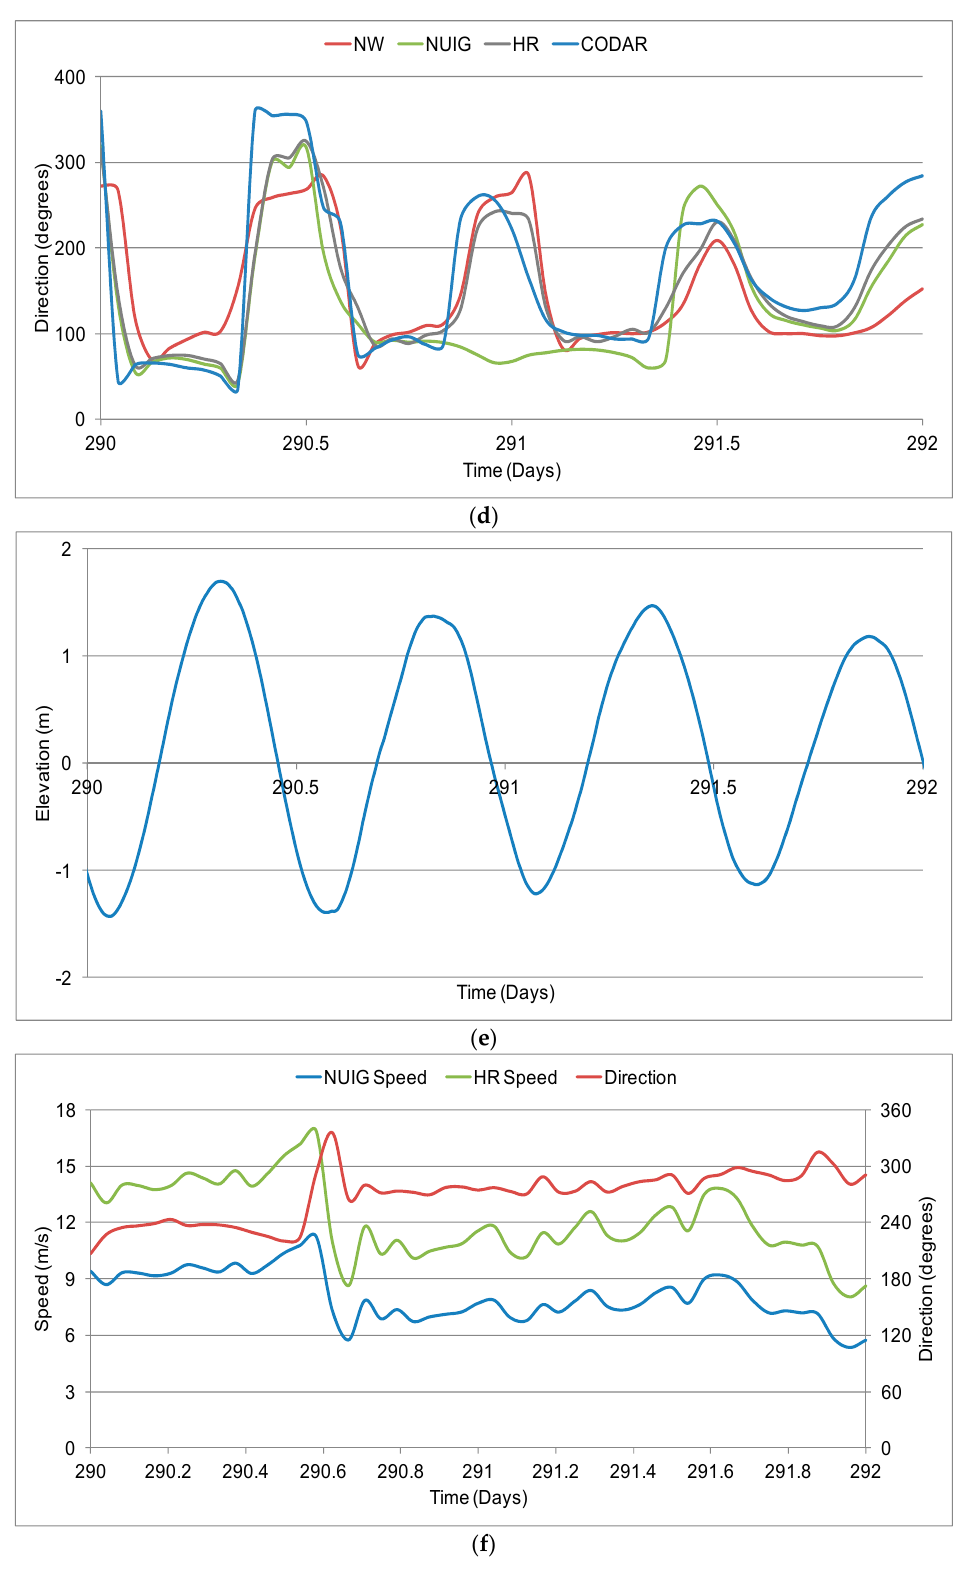
Figure 12. Comparison of model results and observations at location C3 during P1 (( a , b ) east-west (u) and north-south (v) surface velocity components from models and measurements, respectively; ( c ) wind speed; ( d ) wind direction; ( e ) local water elevation; ( f ) wind speed and wind direction at